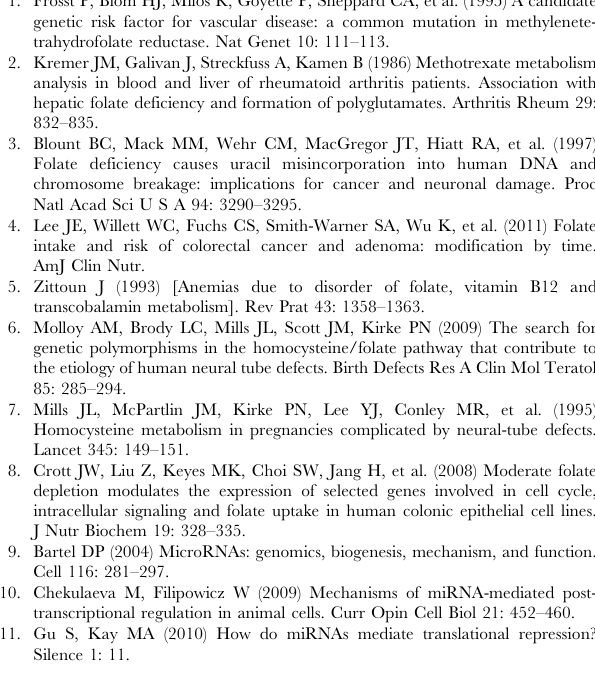
Table S1 Top 5 candidate microRNA master regulators